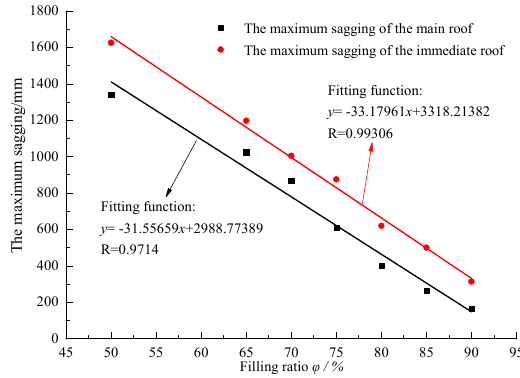
Figure 11. The maximum sagging of the immediate and the main roofs with the filling ratios.